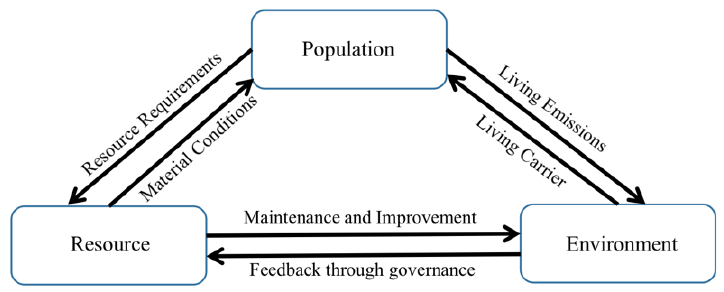
Figure 1. Interaction between PRE systems.